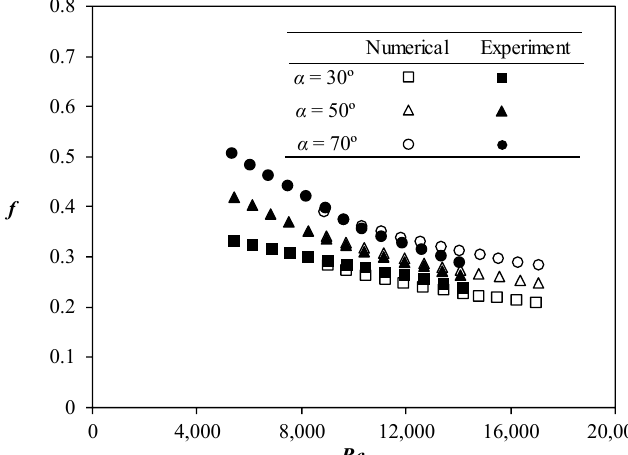
Figure 12. Friction for numerical and experimental results.